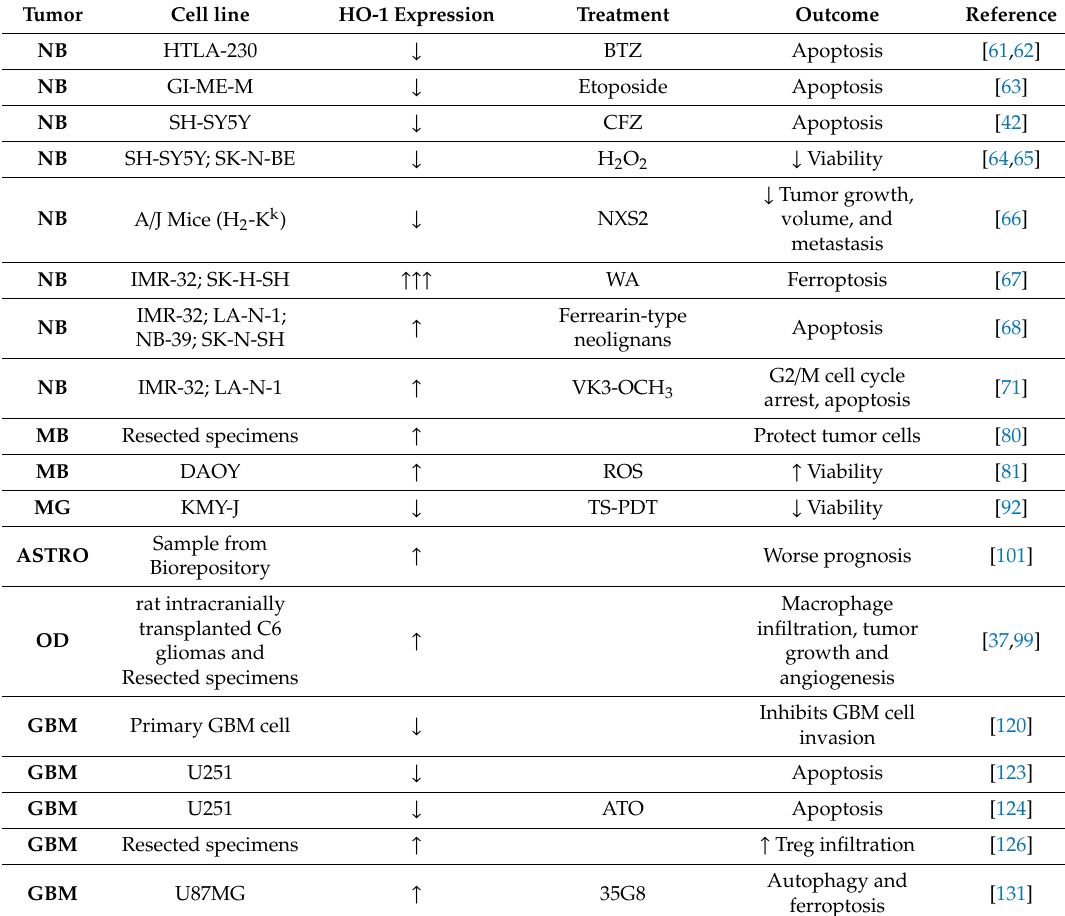
Table 1. List of studies carried out in CNS tumors in which HO-1 expression was analyzed. The table shows tissues or cell lines, HO-1 expression, treatments, and outcomes with relevant references. Tumor Cell line HO-1 Expression Treatment